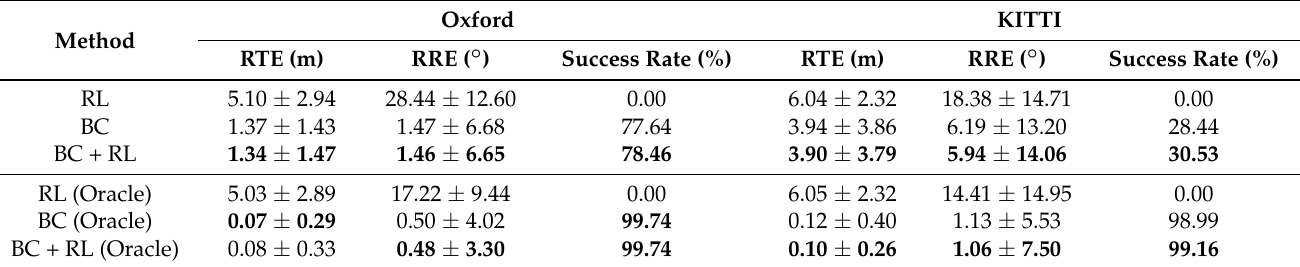
Table 5. Ablation studies. Three variants of AgentI2P were trained and evaluated on both Oxford and KITTI datasets, including RL, BC ,and BC + RL. The average value and standard deviation of RTE and RRE are reported. The notation “Oracle” refers to the frustum classification being substituted by the ground-truth label in the first classification stage. The success rate refers to the percentage of predicted poses falling within the threshold of ( 2 m,5 ◦ ) .